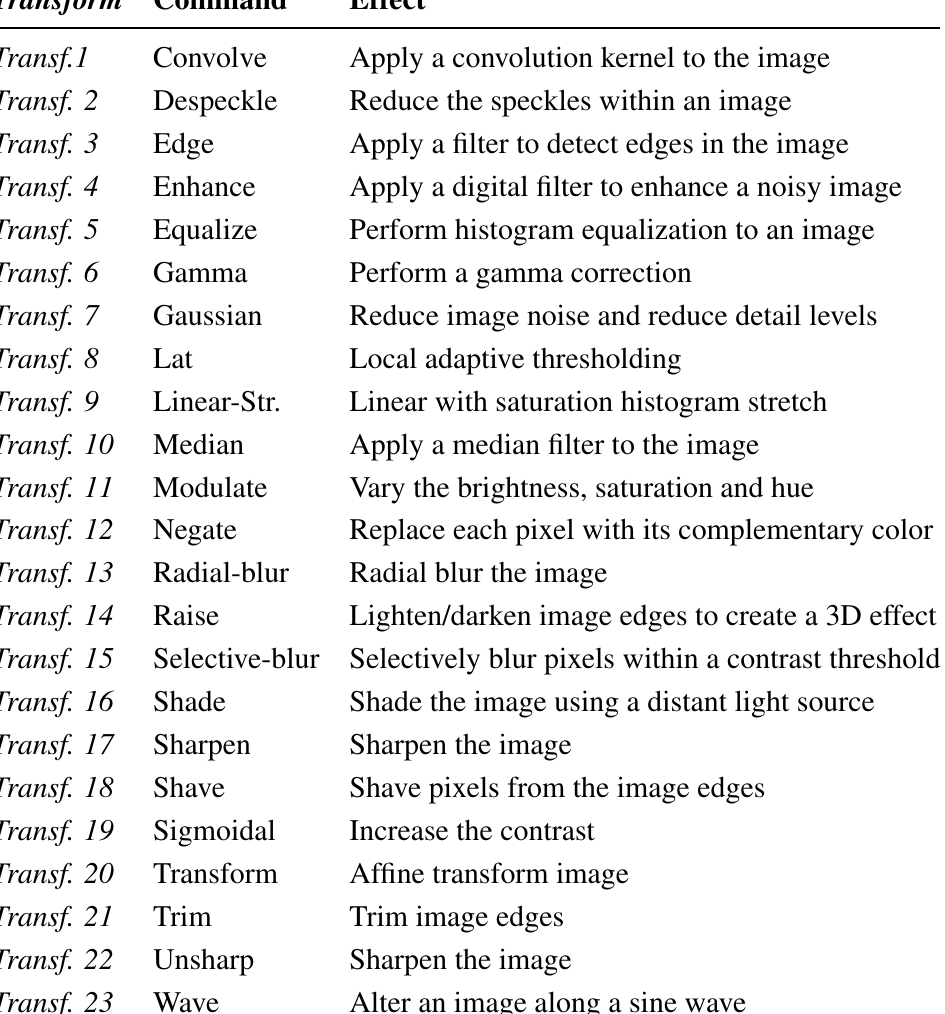
Table 1. Image transformation